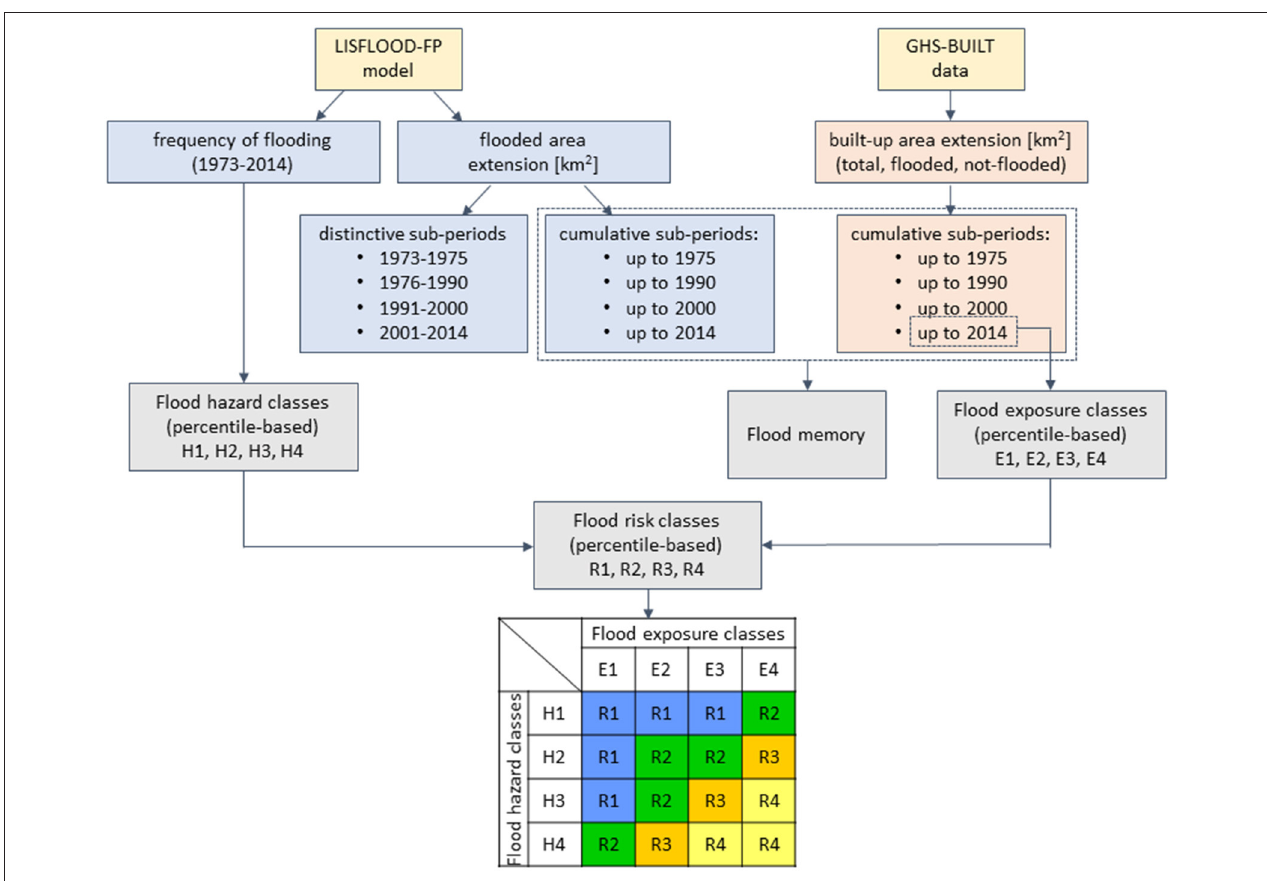
FIGURE 1 | Analysis of long-term flood risk dynamics: research